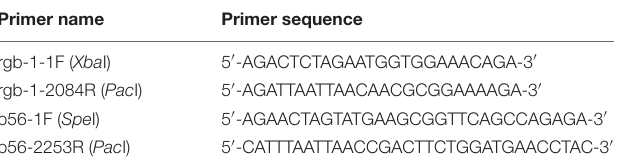
TABLE 2 | Primers used in this study.